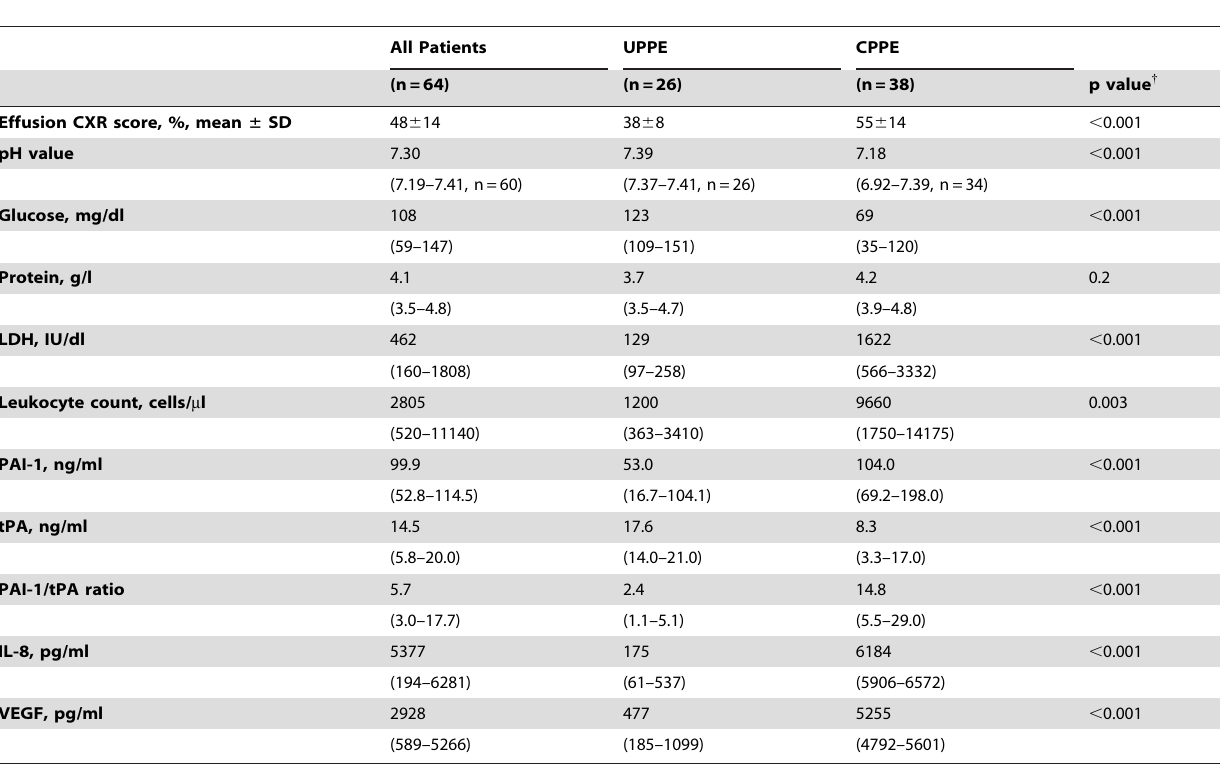
Table 1. Pleural Effusion Size and Variables between Uncomplicated and Complicated Parapneumonic Effusions.